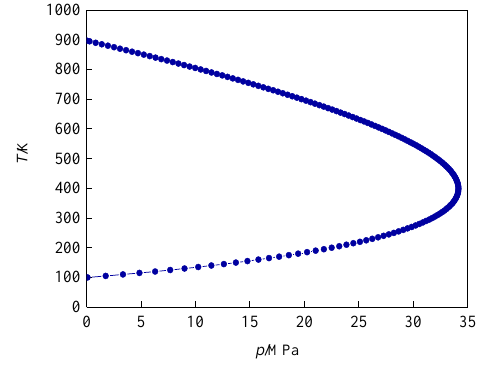
Figure 5. Air inversion curve.